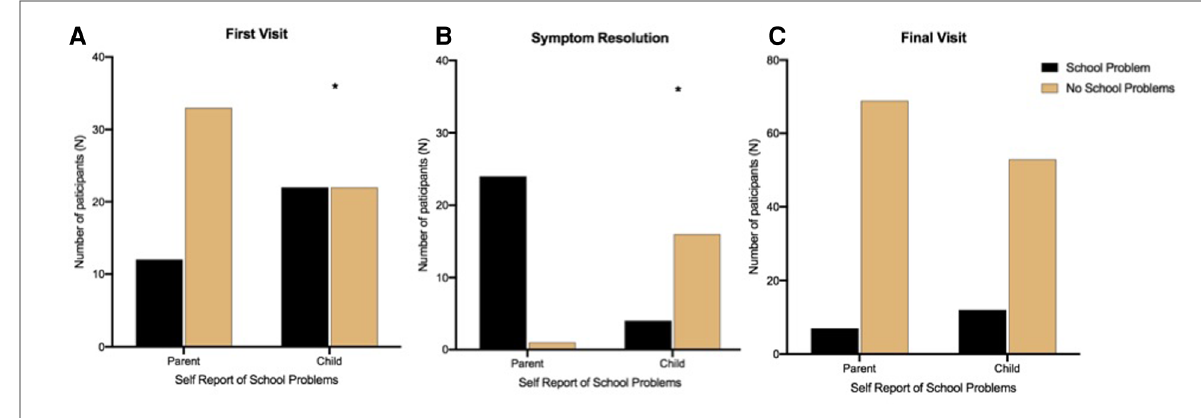
FIGURE 3 School problems reported by parents and youth with concussion.